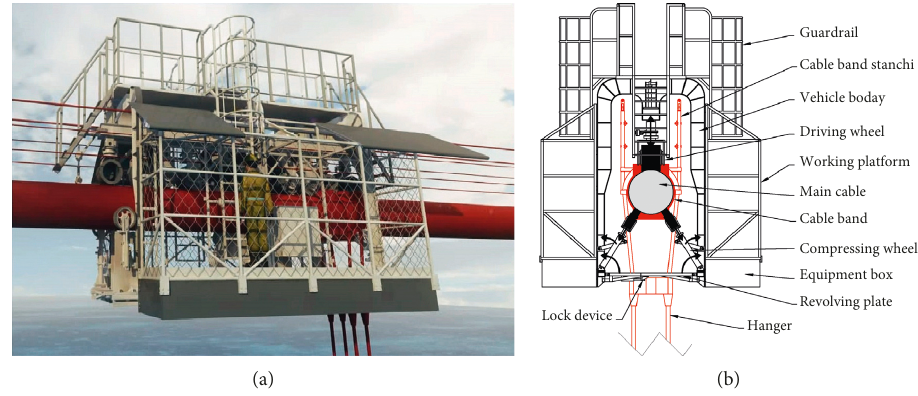
Figure 1: (a) An inspection vehicle for a main cable. (b) Structure of the